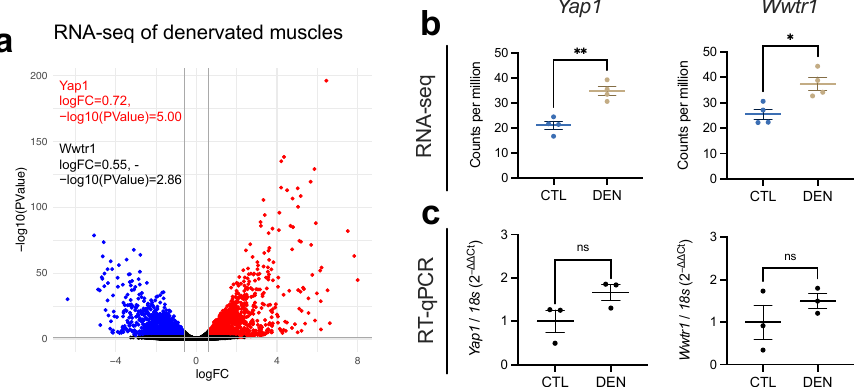
Figure 2. Yap1 and Wwtr1 mRNA levels are increased in denervated skeletal muscles. ( a ) Volcano plot showing differential expression analysis of RNA-seq data of denervated (DEN) vs. control (CTL) GST muscles. Values for Yap1 and Wwtr1 are highlighted. ( b ) RNA-seq analysis (counts per million of mapped reads) of Yap1 and Wwtr1 expressions from DEN and CTL muscles as in ( a ). N = 4 independent mice. * = p < 0.05, ** = p < 0.01; unpaired t test. ( c ) RT-qPCR analysis of Yap1 and Wwtr1 expression in DEN (14 days) and CTL soleus muscles. N = 3 independent mice. ns = not significant; unpaired t test.